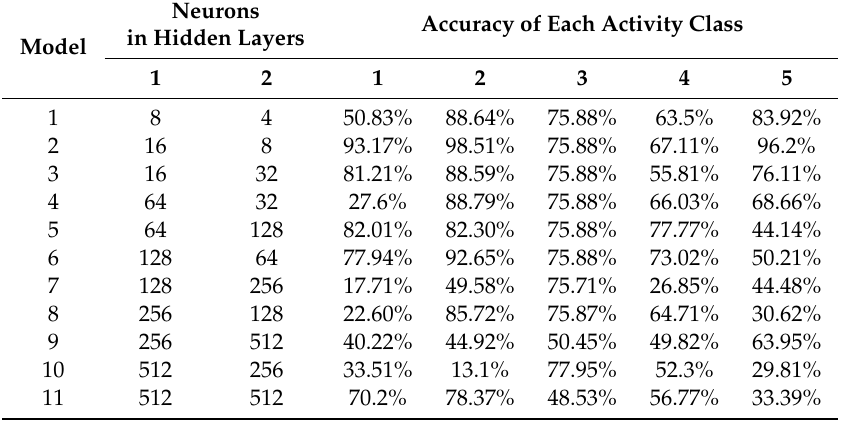
Table 10. Scoring result of training dataset B (26 July 2019 interval) and evaluation dataset A (19 July 2019